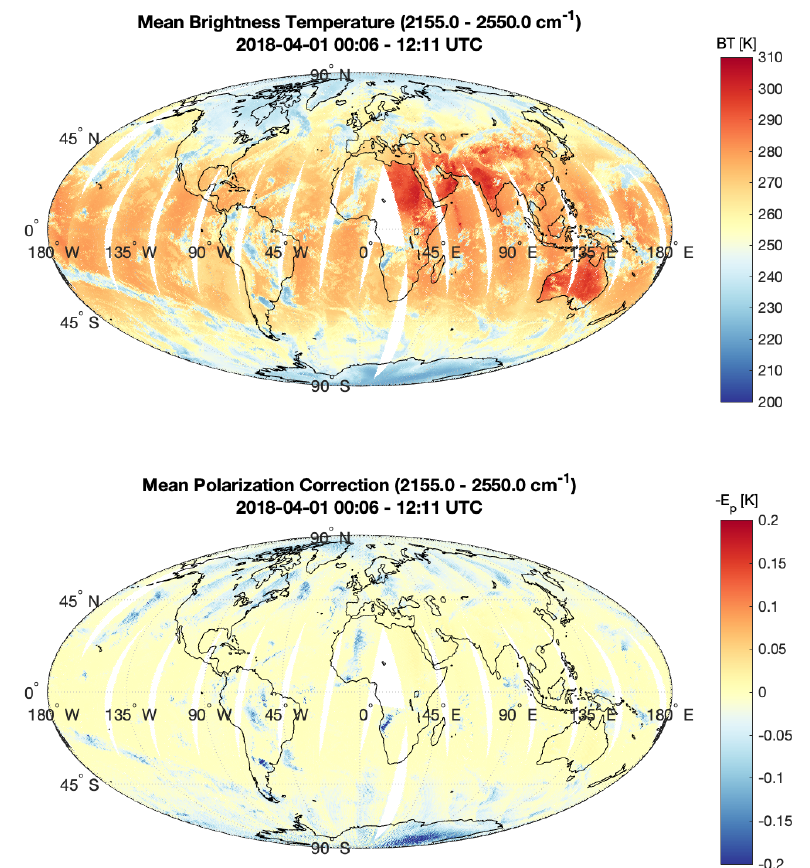
Figure 20. NOAA-20 CrIS shortwave band-averaged brightness temperature map (top panel) and corresponding band-averaged polarization correction for 12 h of data on 1 April 2018 (00:06–12:11 UTC).